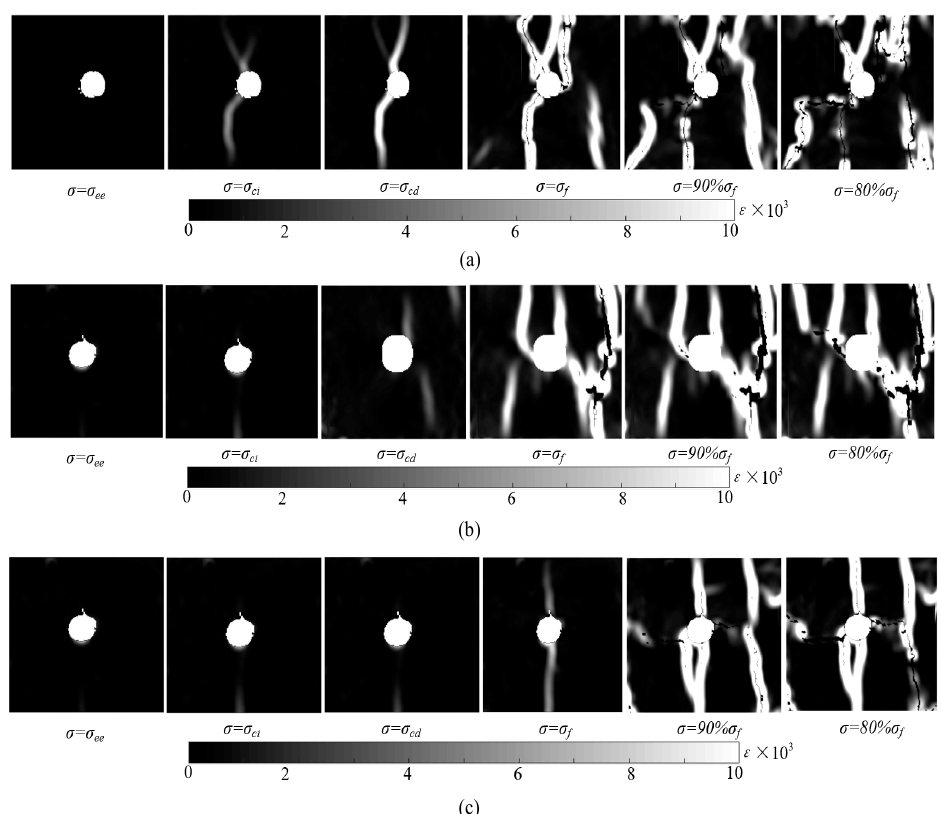
Figure 4. Grayscale cloud of the specimen progressive failure strain. ( a ) HS-0%. ( b ) HS-20%. ( c ) HS-40%.